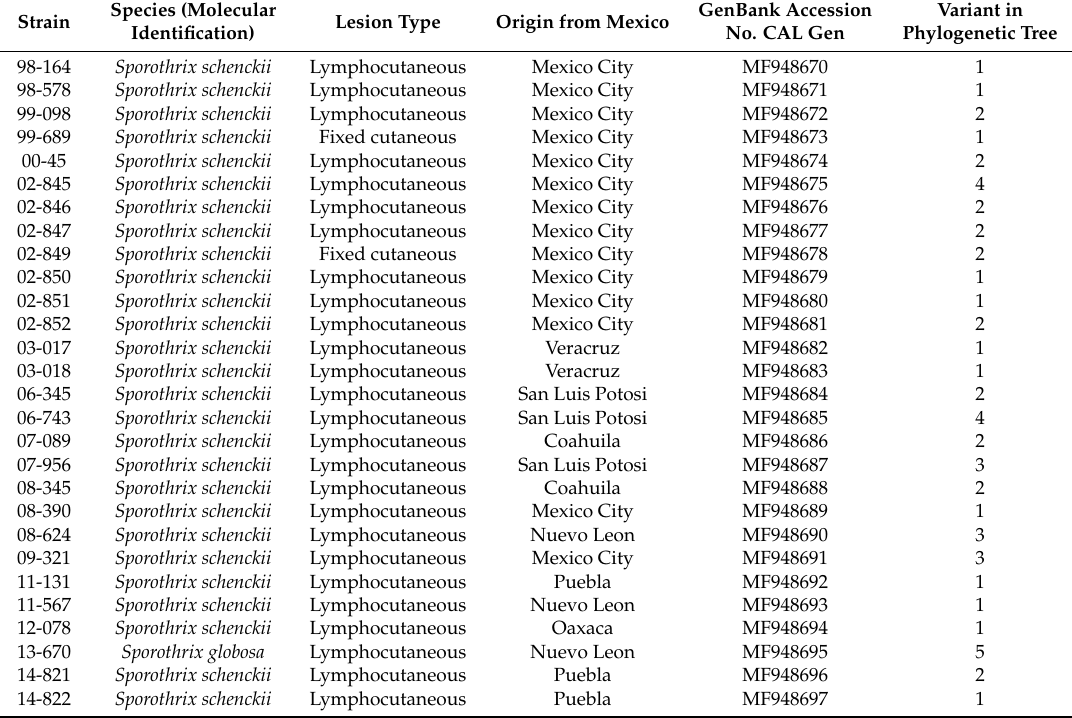
Table 1. Data of clinical human sporotrichosis and molecular analysis used in this study. Species (Molecular Strain Lesion Type Identification)